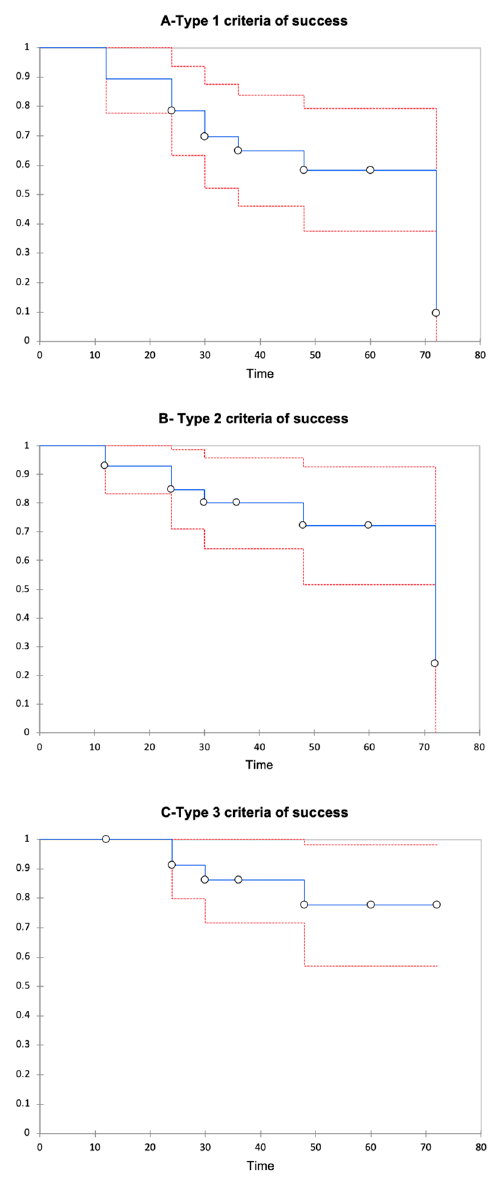
Figure 3. Kaplan–Meier survival curve in all populations. Kaplan–Meier survival curve, showing the success rate of a second Ahmed Glaucoma Valve implantation in subjects with previous failure of the AGV in the same eye. The success rate of the second AGV was calculated based on the criteria of success Types 1 ( A ), 2 ( B ), and 3 ( C ); time is expressed in months.